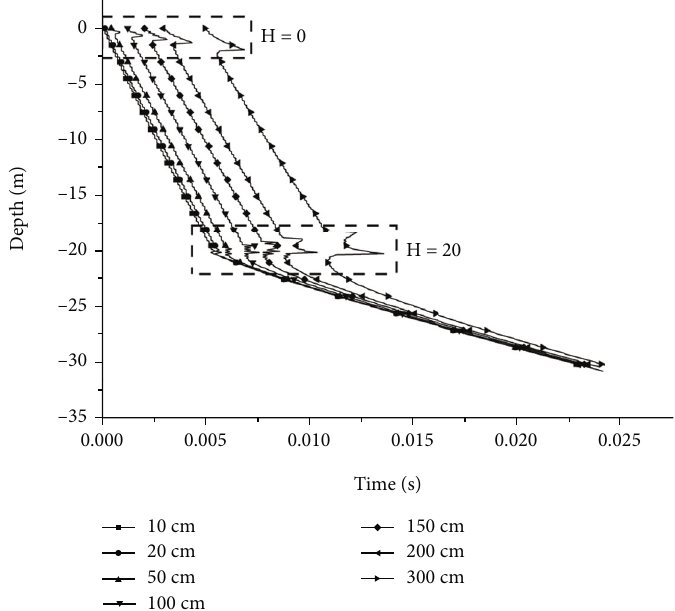
Figure 8: Time-depth comparison for di ff erent hole